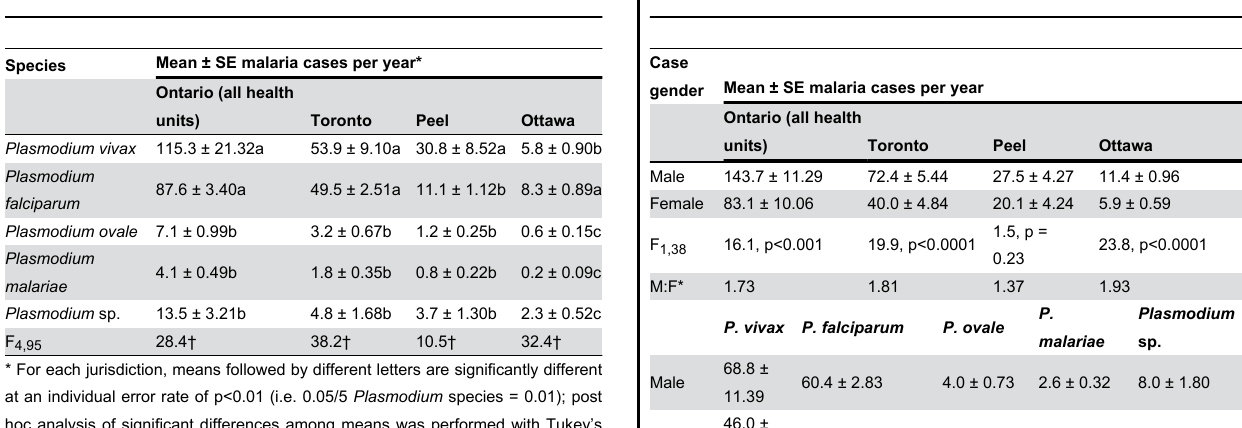
Table 1. Imported malaria cases by Plasmodium agent in Ontario, Canada (1990–2009).